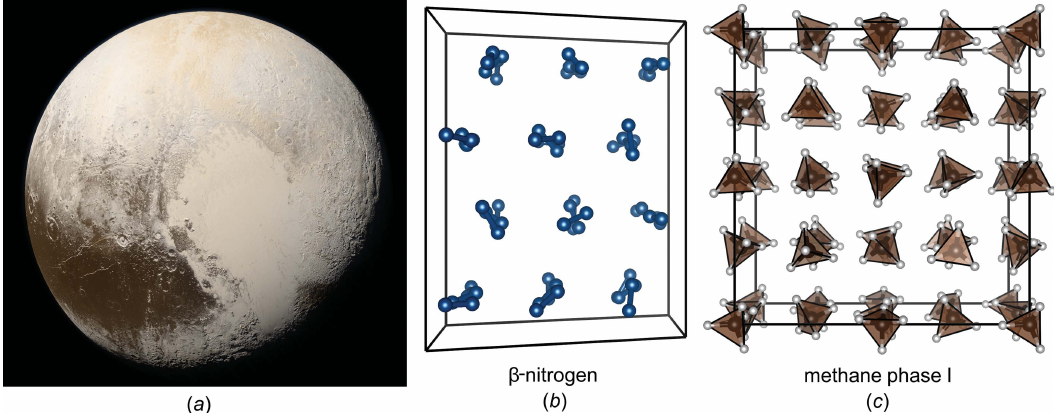
Figure 1 Pluto and the crystals structures of two of its most important minerals. ( a ) Photographic image of Pluto taken by the New Horizons spacecraft (Source: NASA/Johns Hopkins University Applied Physics Laboratory/Southwest Research Institute/Alex Parker. Published: July 23, 2018). ( b , c ) Crystal structures of (cid:2) -nitrogen(Streib et al. , 1962, Press et al. , 1982) and methane I(Press, 1972) shown with random orientations of the N 2 and CH 4 molecules, and using 3 (cid:3) 3 (cid:3) 2 and 2 (cid:3) 2 (cid:3) 2 supercells,